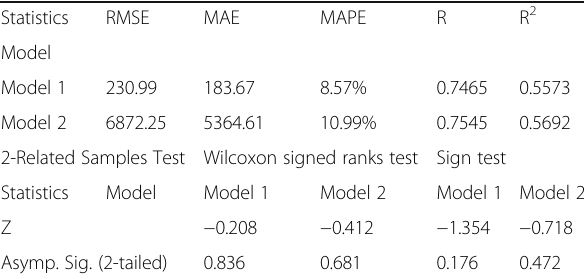
Table 3 Regression goodness for the estimated models and